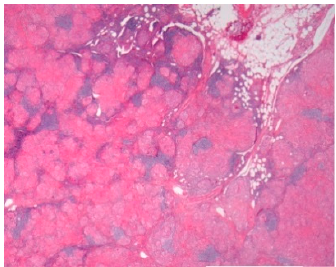
Figure 1. Mediastinal nodal sarcoidosis. H&E Magnification 20×.